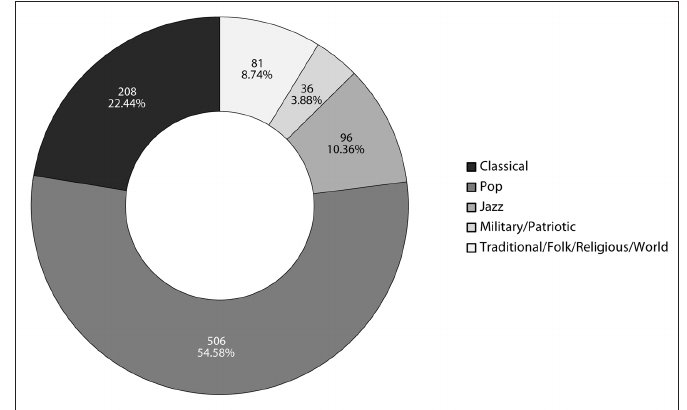
Figure 7: Total references by genre (absolute and relative).